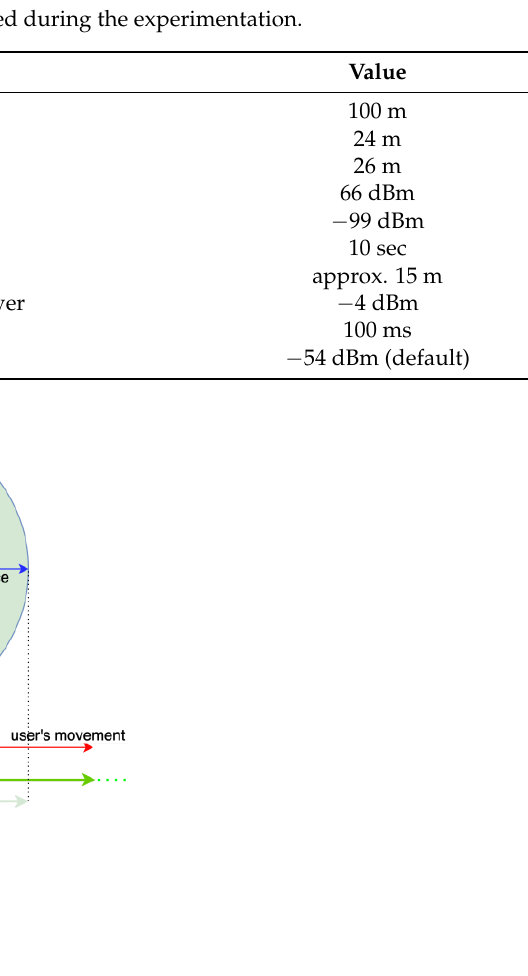
Figure 3. Detecting exit stop. 4. The Beep4Me Ticket Validation Algorithm 4.1. Beep4Me Workflow After updating the app with the Beep4Me system, the new functionalities which al- low to simplify ticket validation procedures, usually executed while traveling on public transport, will be presented to users by means of a pop-up window. Users will receive the option to enable the new automatic validation functionalities by activating a switch in the app, which they will find in their ticket wallet. The app-side user experience is based com- pletely on the use of push notifications and banners giving them updates on their trips and on the status (i.e., validation) of their tickets. These notifications provide them with a visual confirmation of the check-in and check-out events, and thus of the correct operation of the whole system, while requiring a minimal amount of actions to successfully perform a validation. Figure 4 shows the workflow of the algorithm from the activation of the Beep4Me functionalities up to the moment in which the check-in operations have been completed.